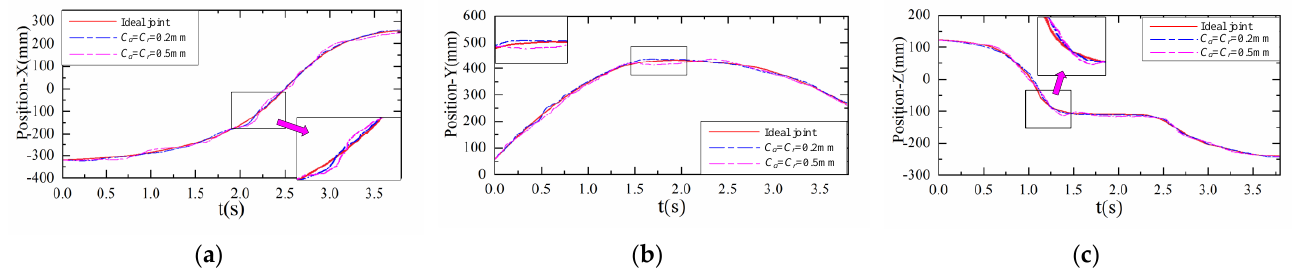
Figure 9. Displacement curves of the end effector along the X , Y , and Z axes. ( a ) The displacement curve along the X −axis direction in the frame O − XYZ ; ( b ) the displacement curve along the Y −axis direction in the frame O − XYZ ; and ( c ) the displacement curve along the Z −axis direction in the frame O − XYZ .